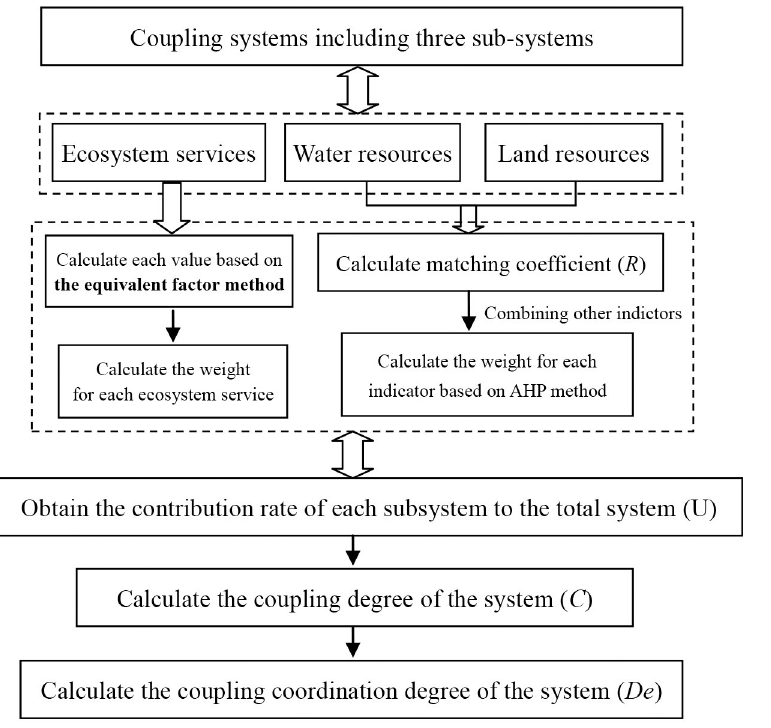
Fig 2. The flow chart shows the linkages between the different methodological approaches.